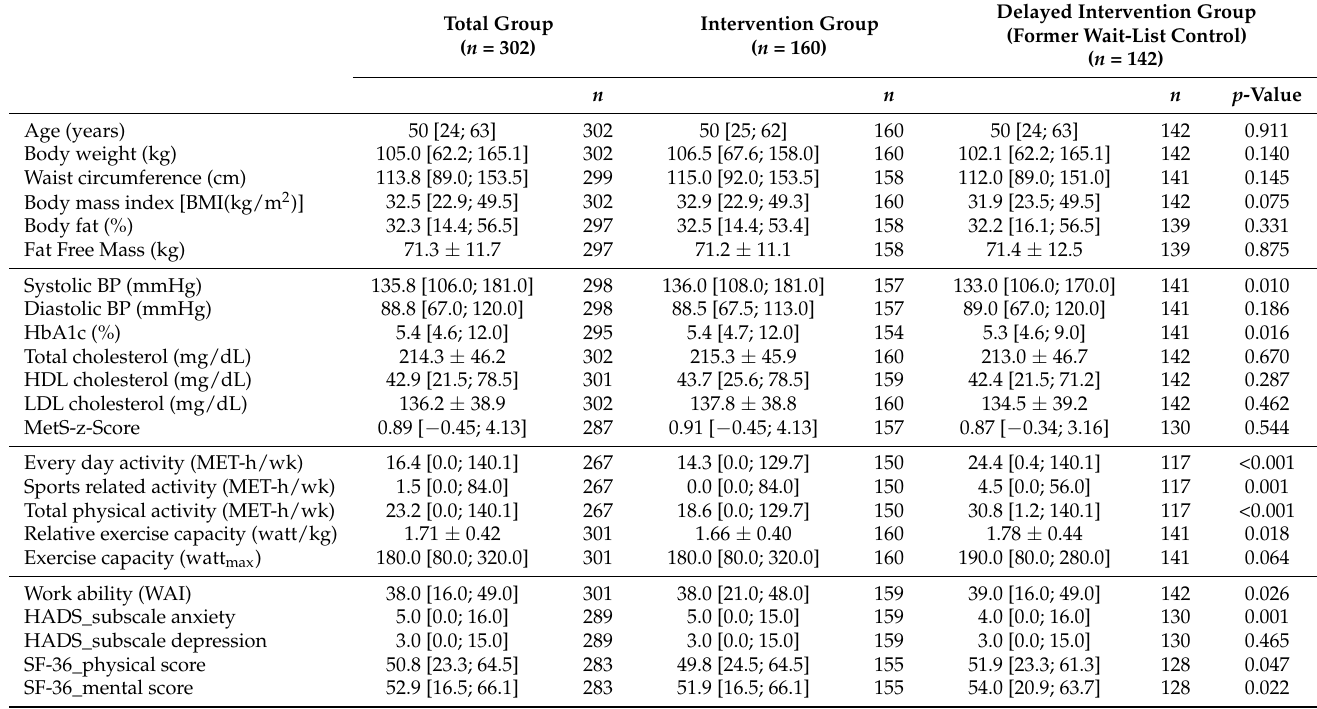
Table 1. Subject Characteristics at Start of